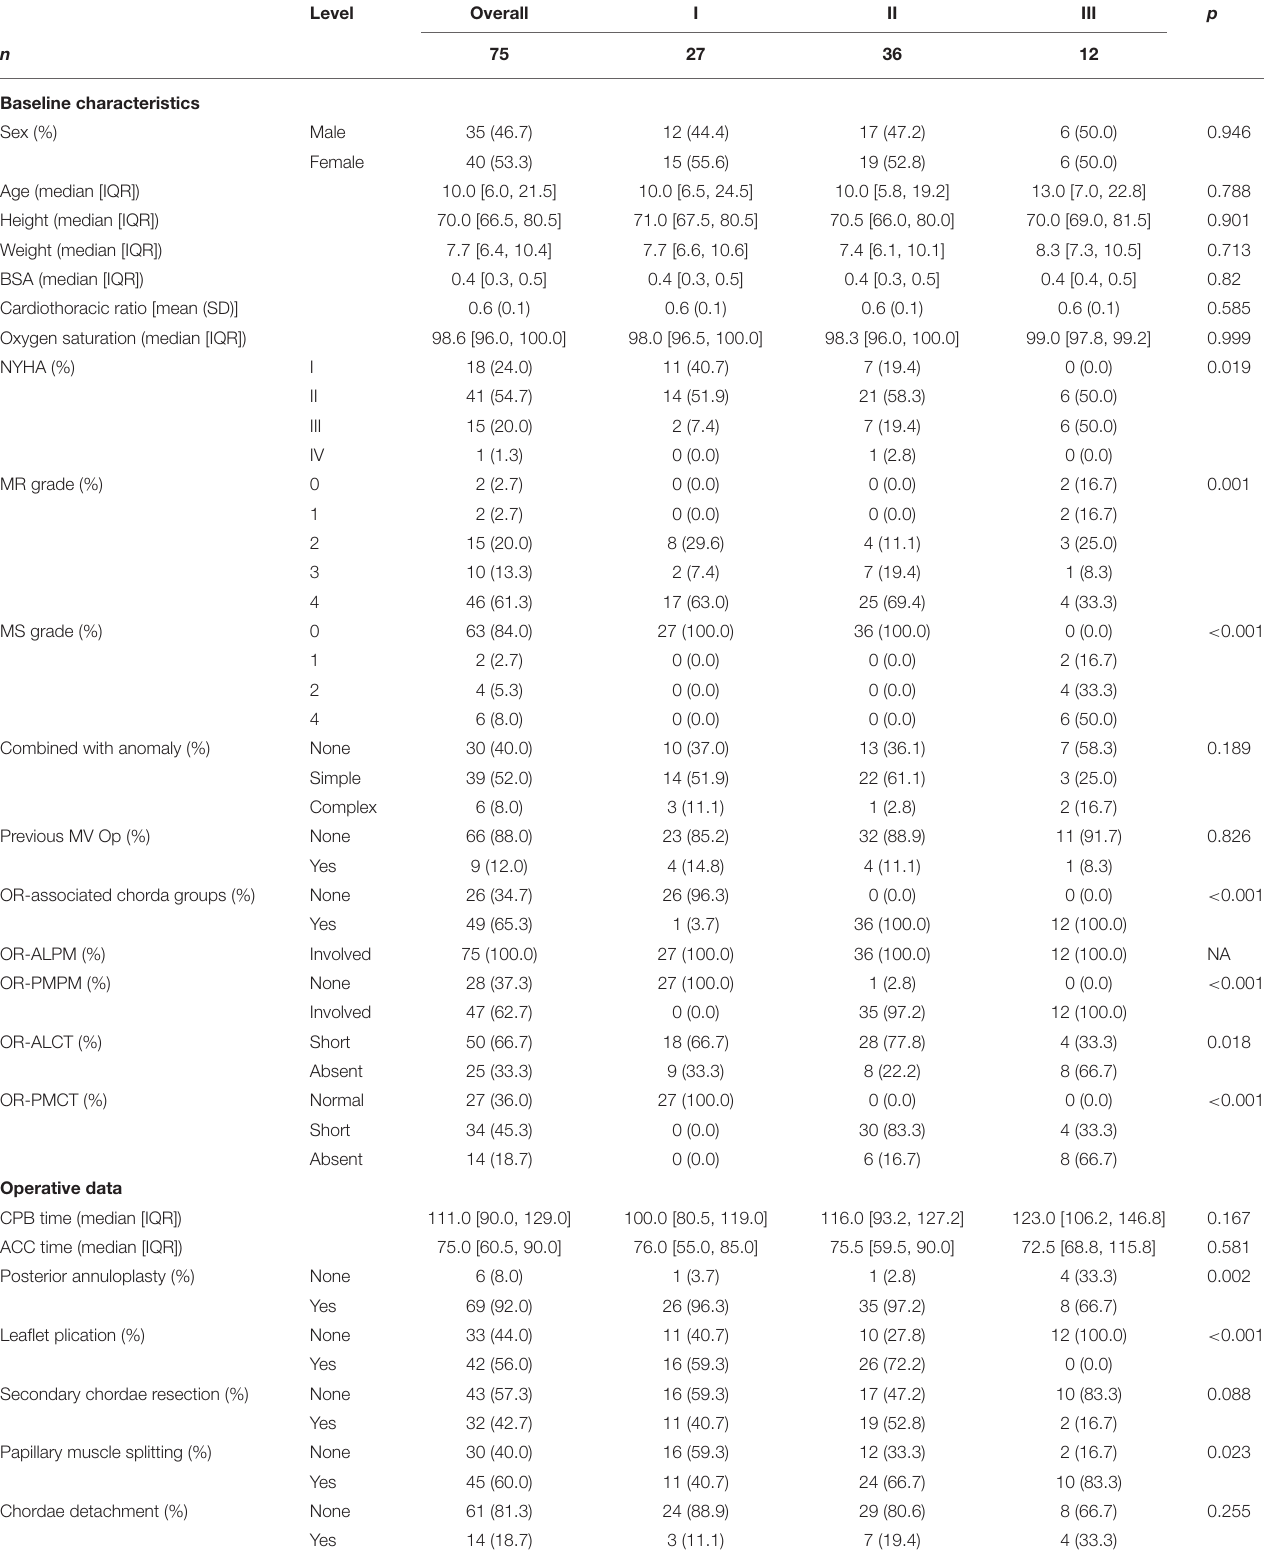
TABLE 2 | Characteristics of the three classes of